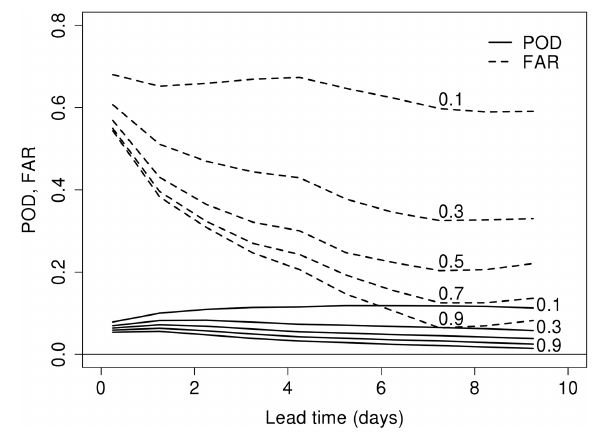
Figure 6. POD and FAR versus lead time, for different probability thresholds between 10 and